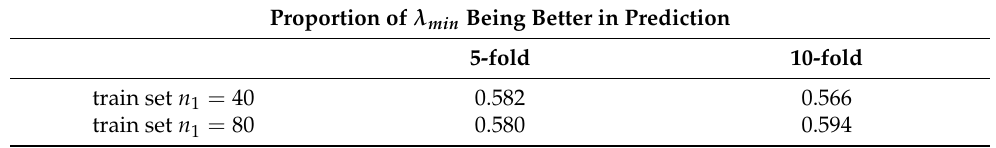
Table 3. Regression estimation (cross validation):